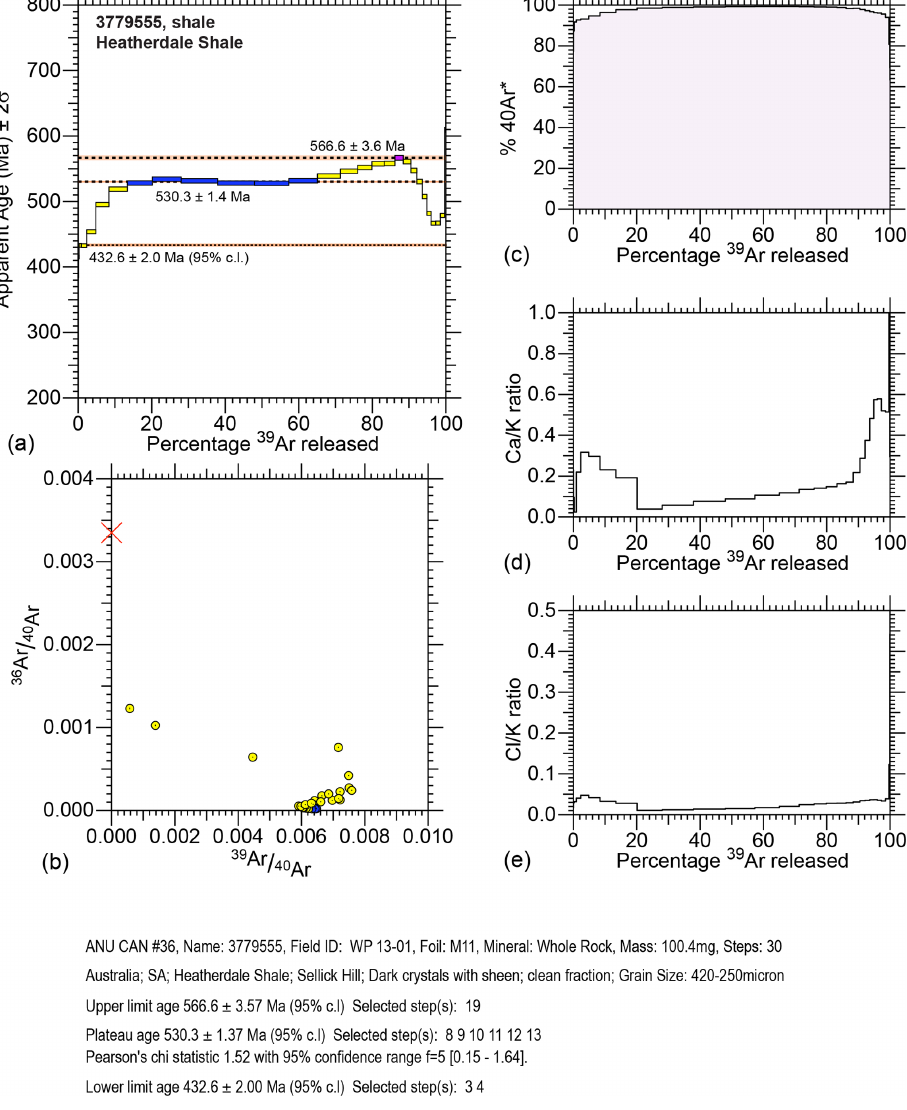
Figure C6. Sample 3779555 (a) age spectrum, (b) isotope correlation diagram, (c) percentage radiogenic 40 Ar ( 40 Ar ∗ ), (d) Ca / K ratio, and (e) Cl / K